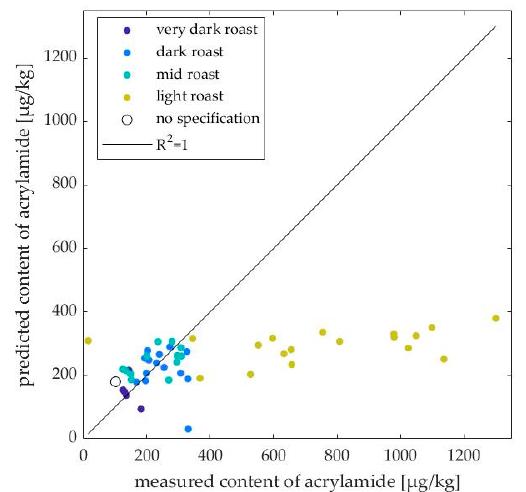
Figure 4. Correlation between the predicted content of acrylamide (µg/kg) and the measured con-